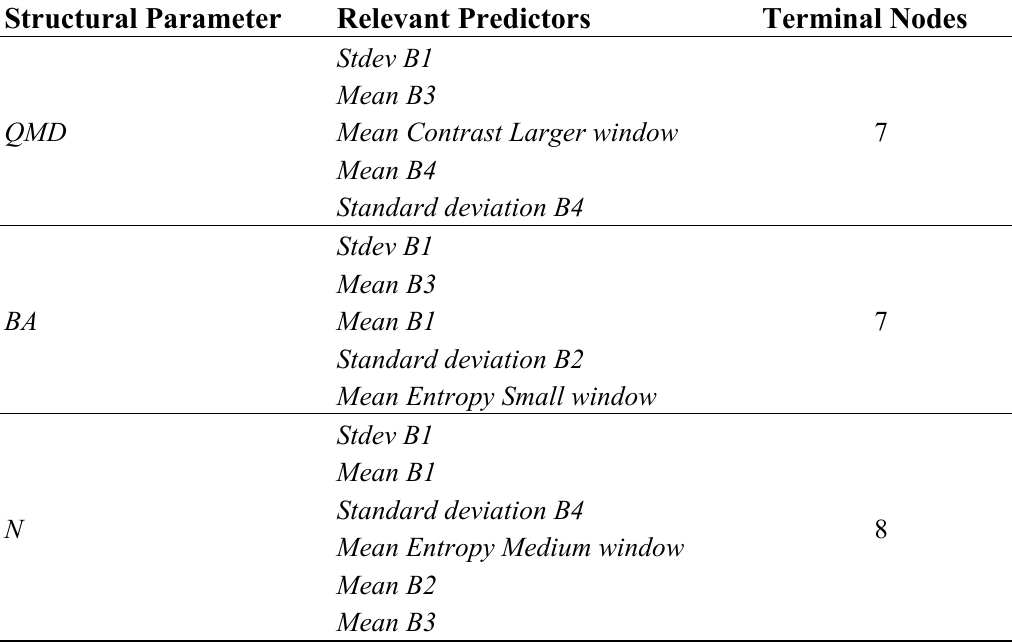
Table 7. Relevant predictors in regression trees of QMD, BA and N and number of terminal nodes. Structural